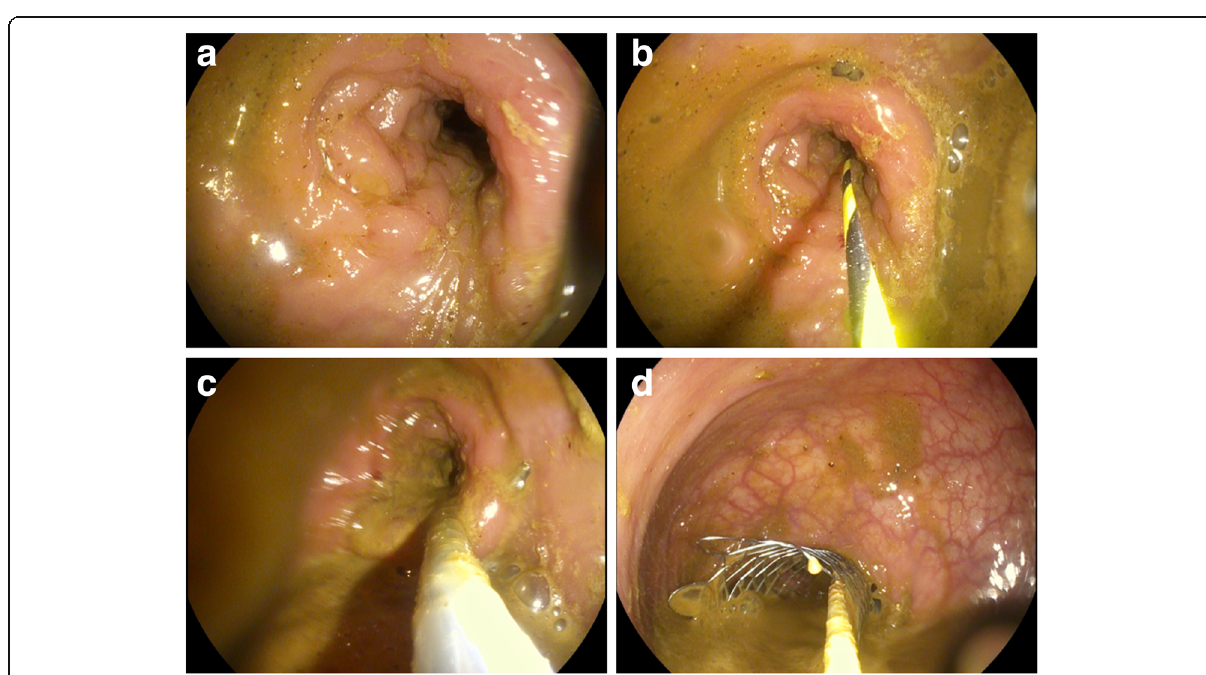
Fig. 2 Endoscopic placement of a SEMS through an obstructing tumour of the sigmoid colon. a Distal endoscopic view of colorectal carcinoma (CRC) impassable with the endoscope. b Under fluoroscopic guidance, the guidewire is passed through the stricture. c The SEMS is advanced along the guidewire. d After deployment and initial expansion of the SEMS, prompt outflow of faecal content is